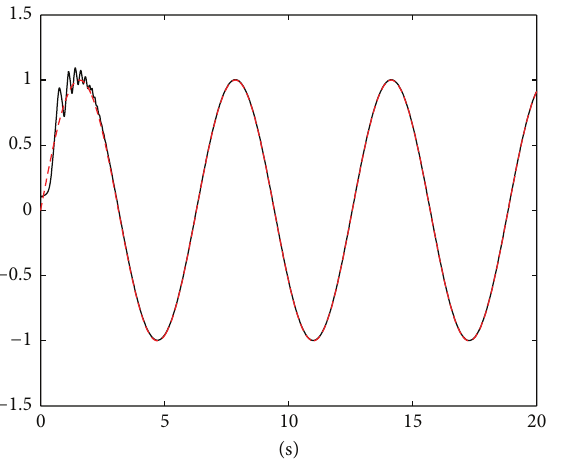
Figure 4: The curves of 𝑢 1 (solid) and 𝑢 2 (dash).